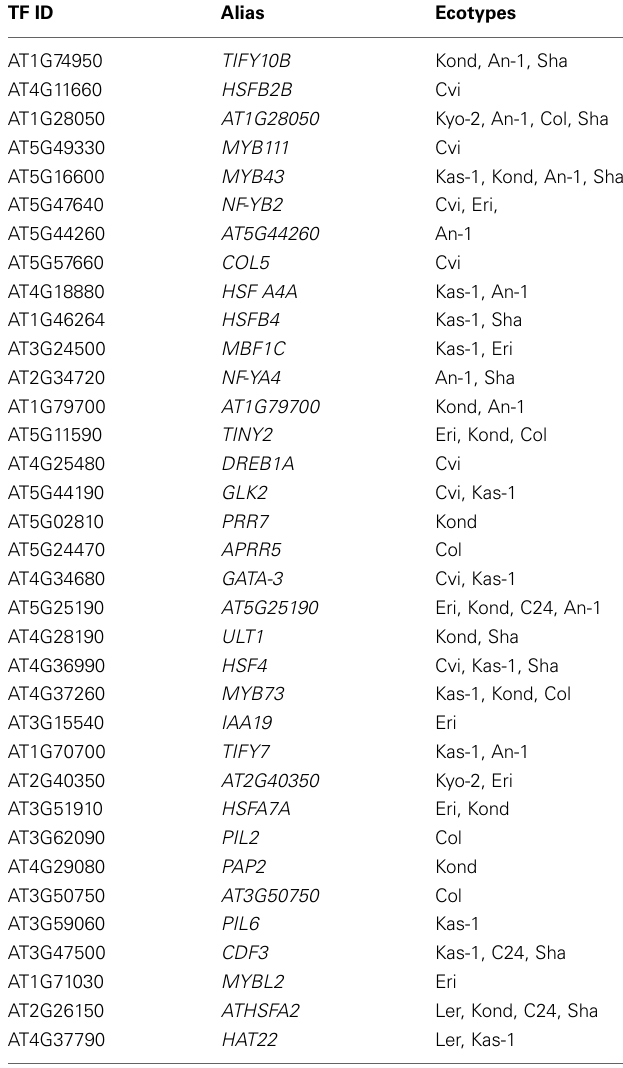
Table 3 | Ecotype specific transcriptional activity profiles of the 35 heat responsive